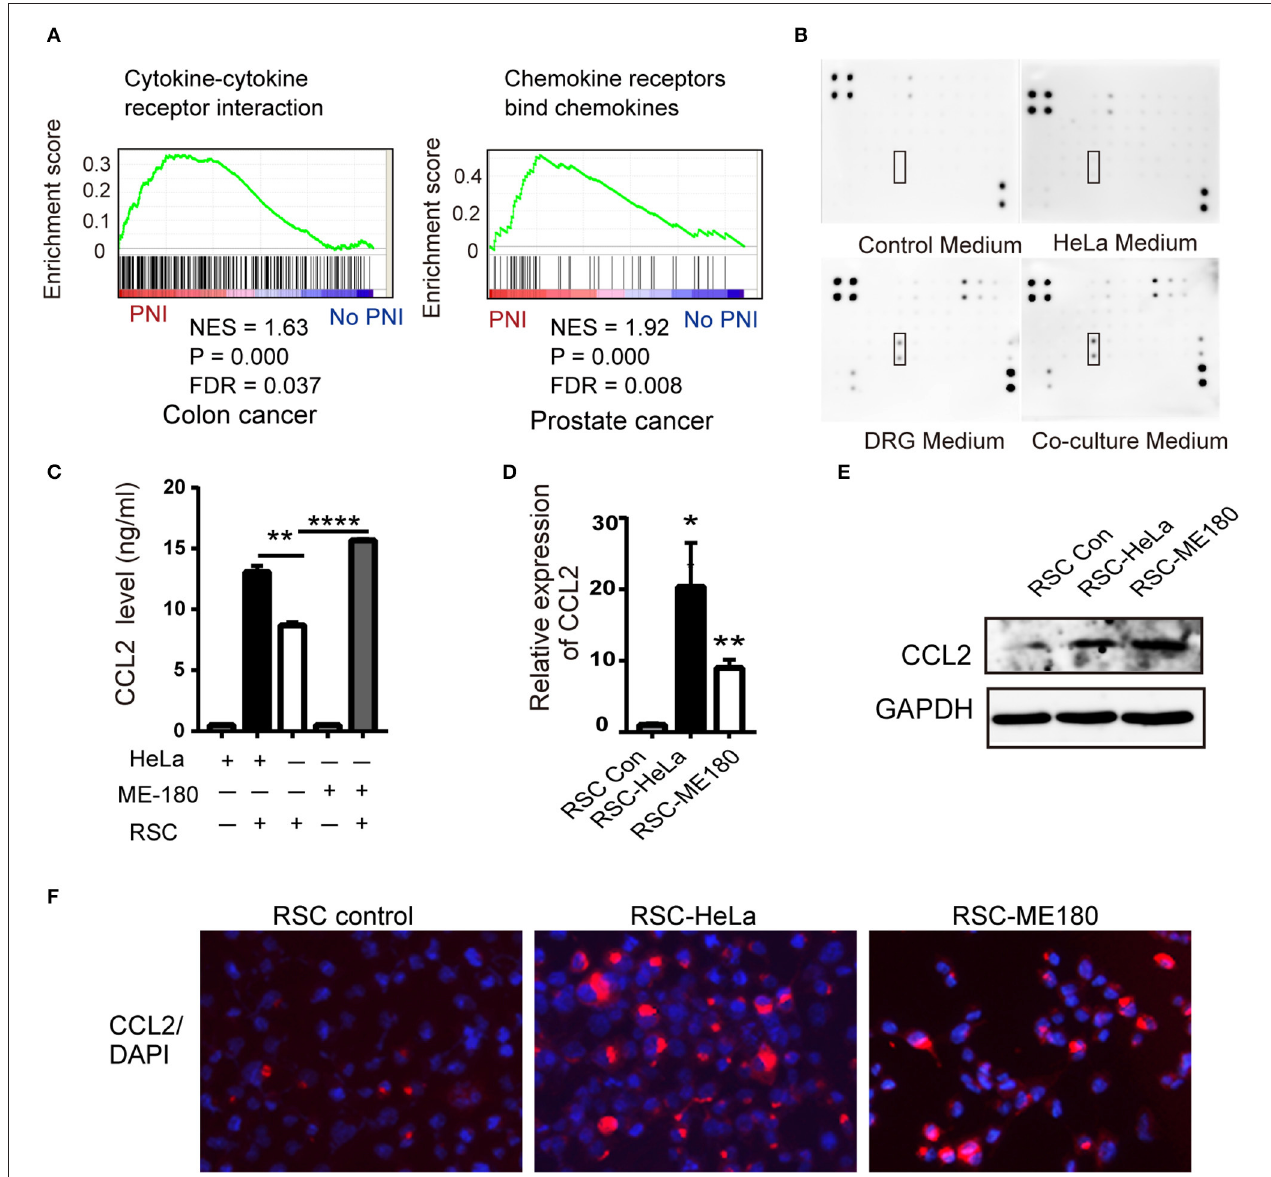
FIGURE 3 | CCL2 is expressed in DRGs and SCs. (A) GSEA results shows the correlation of PNI and cytokine and cytokine receptor interaction in colon cancer as well as PNI and the chemokine receptor in prostate cancer. NES normalized enrichment score, FDR false discovery rate. (B) Cytokine array of DRG